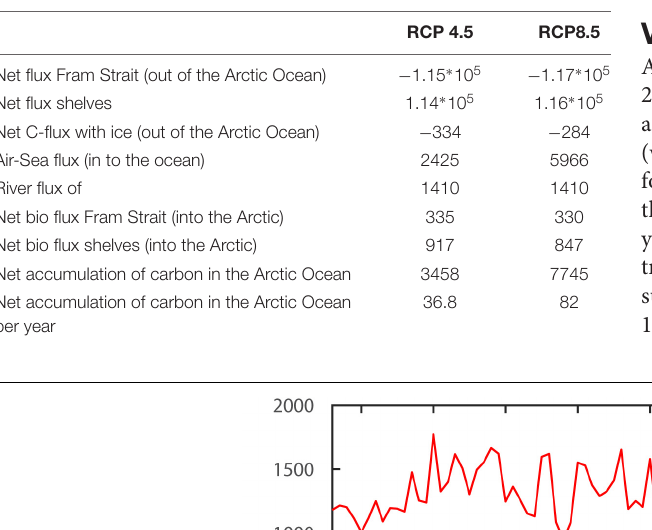
TABLE 1 | Integrated fluxes (2006–2099) in Teragram carbon (TgC).